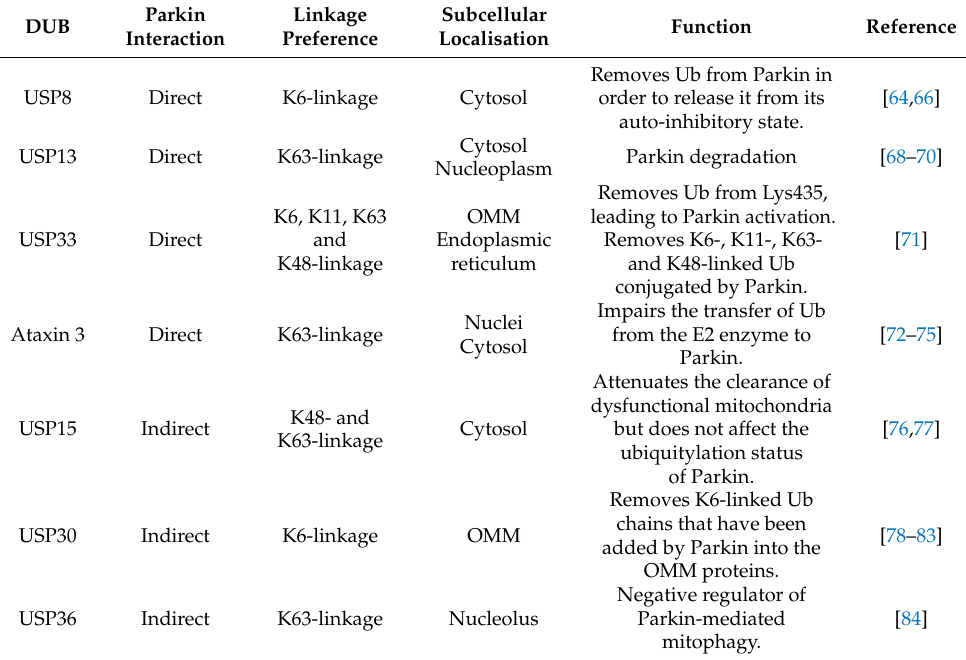
Table 1. Deubiquitinating enzymes (DUBs) that regulate Parkin